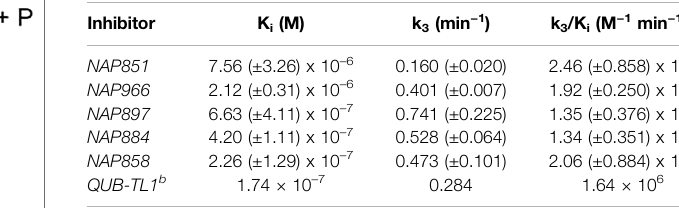
TABLE 2 | Kinetic constants determined for the inhibition of trypsin with NArg